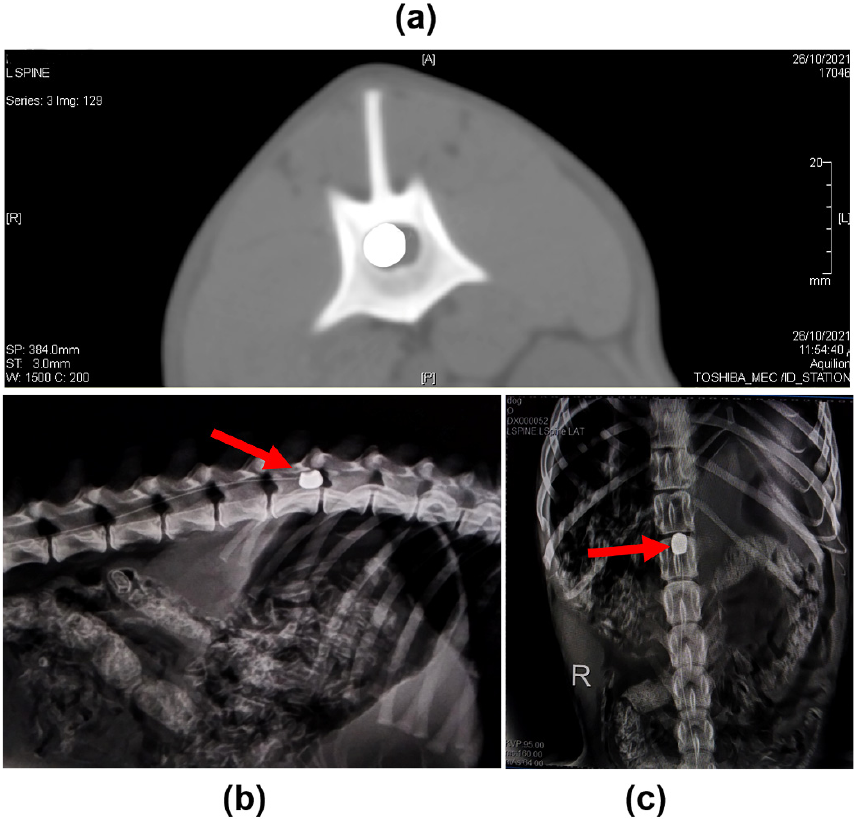
Figure 1. SCI induction using the balloon compression approach. ( a ) Transverse CT image at the level of L1 after balloon inflation. ( b ) Plain radiography (lateral view) after balloon inflation at the level of L1 (red arrow). ( c ) Plain radiography (Dorso-ventral view) of the same image is shown in ( b ) (red arrow).